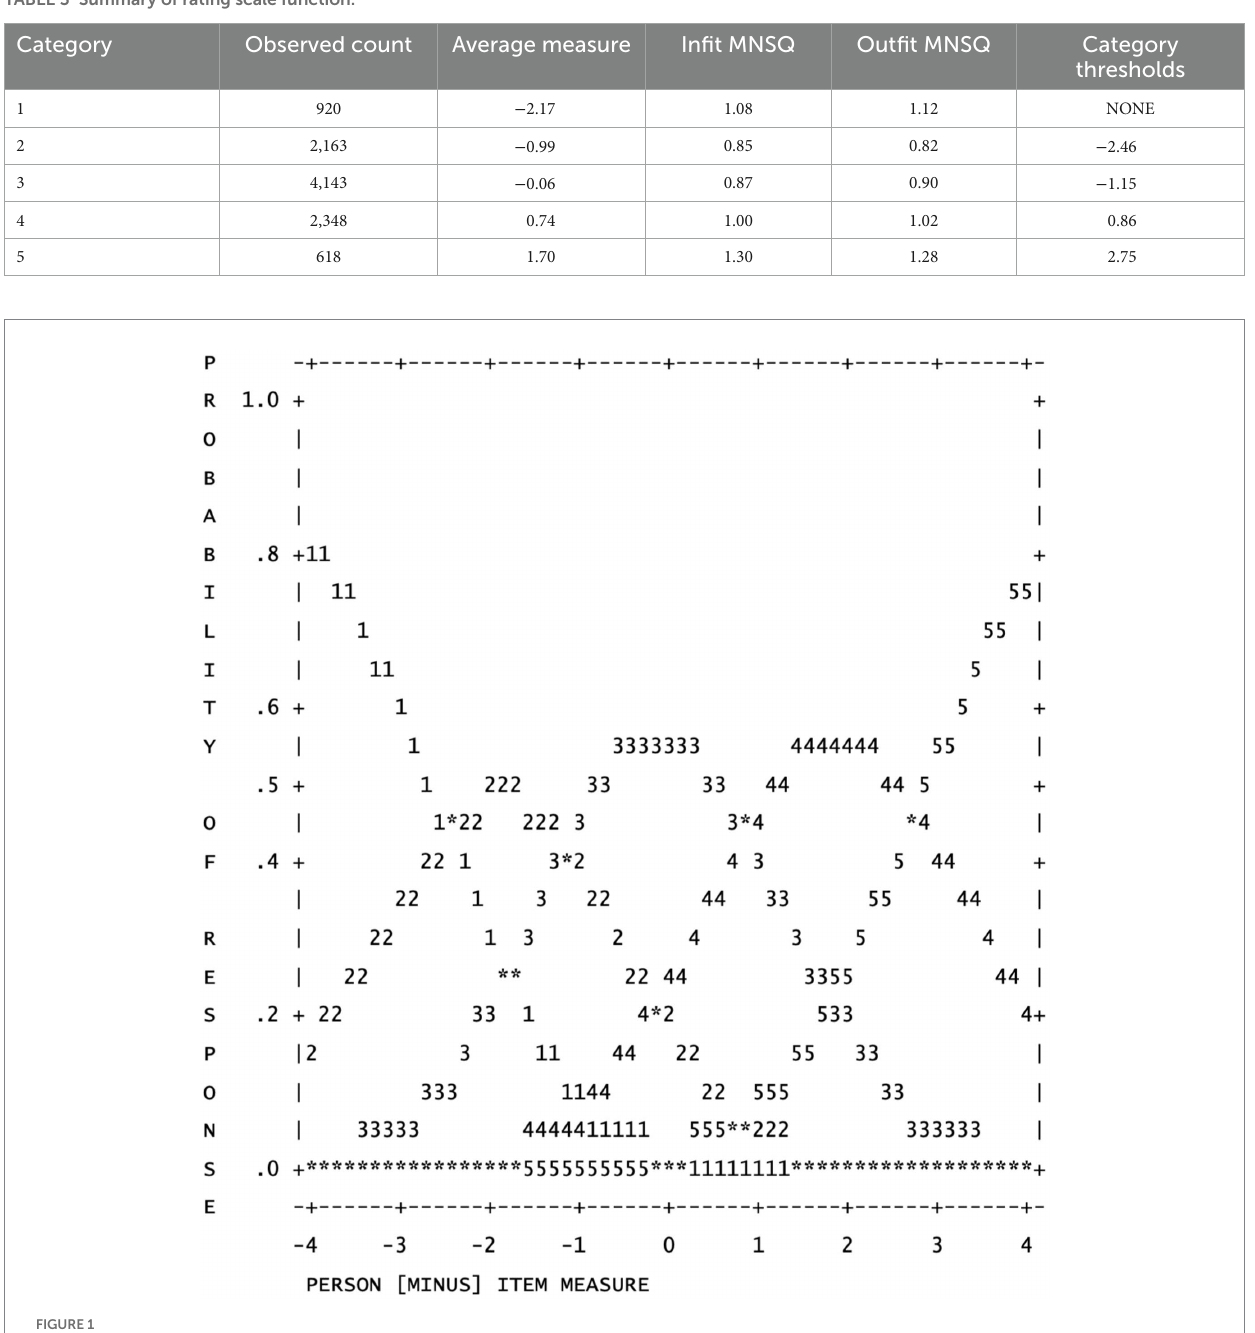
TABLE 3 Summary of rating scale function.